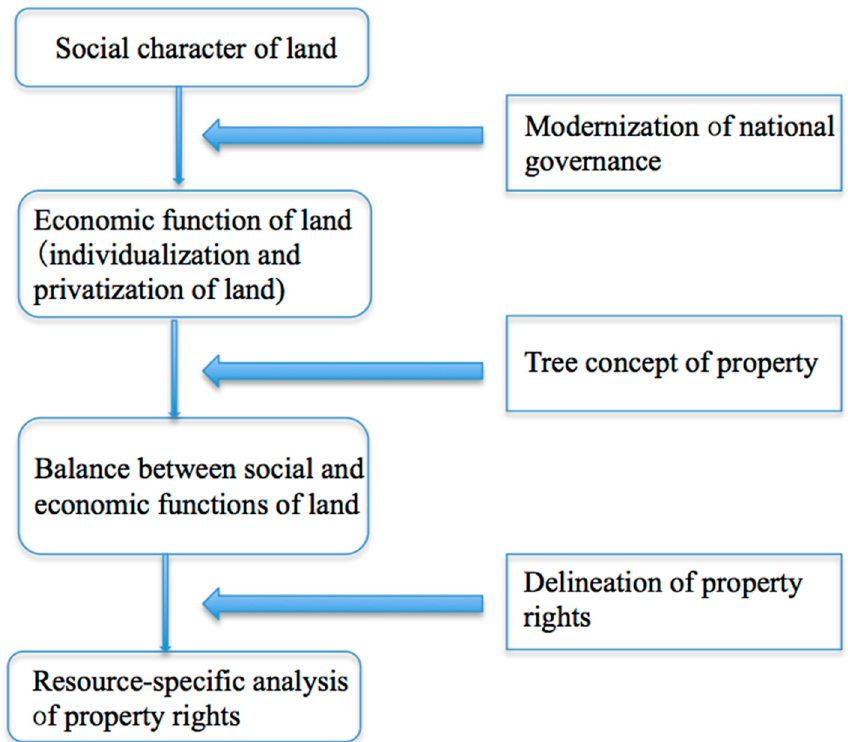
Figure 1. A three-level understanding of the “trifurcation of land rights” reform in China.